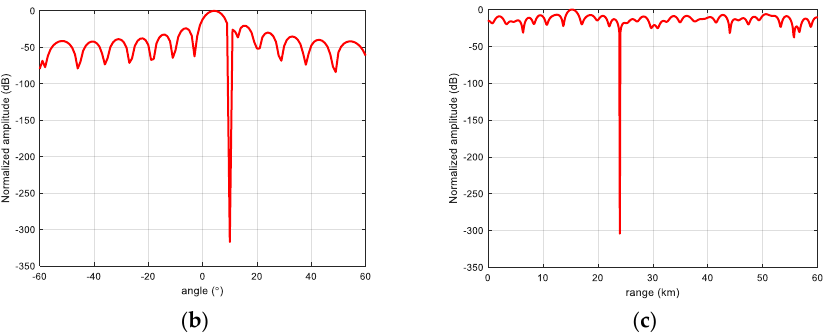
Figure 11. Proposed scheme performance. ( a ) The proposed scheme; ( b ) Range-dimensional slicing; and ( c ) Angle-dimensional slicing.